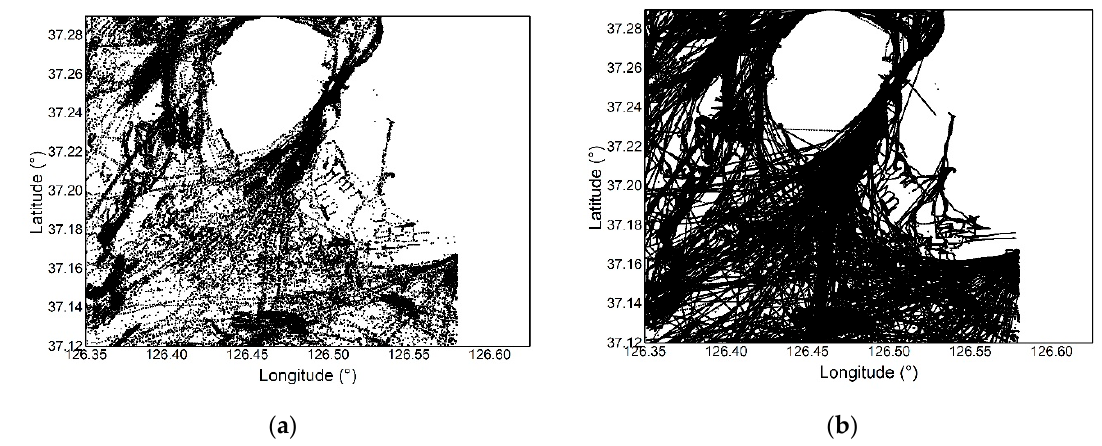
Figure 7. ( a ) Vpass data plot for 7 days and ( b ) the plot after the interpolation of Vpass data with 10 s intervals for 7 days.